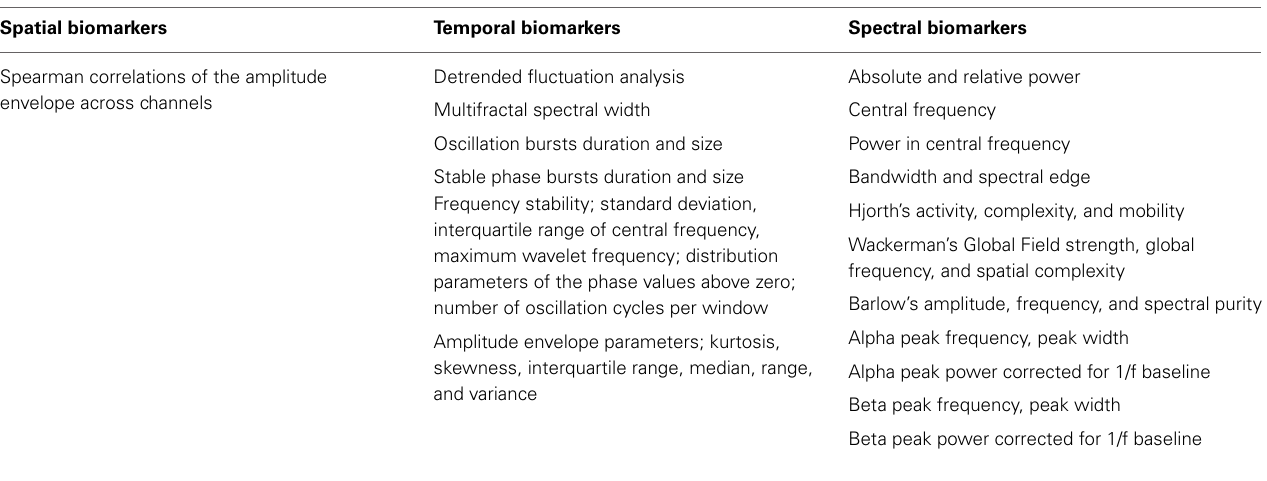
Table 1 | Thirty-five biomarkers from different signal processing domains were extracted. Spatial